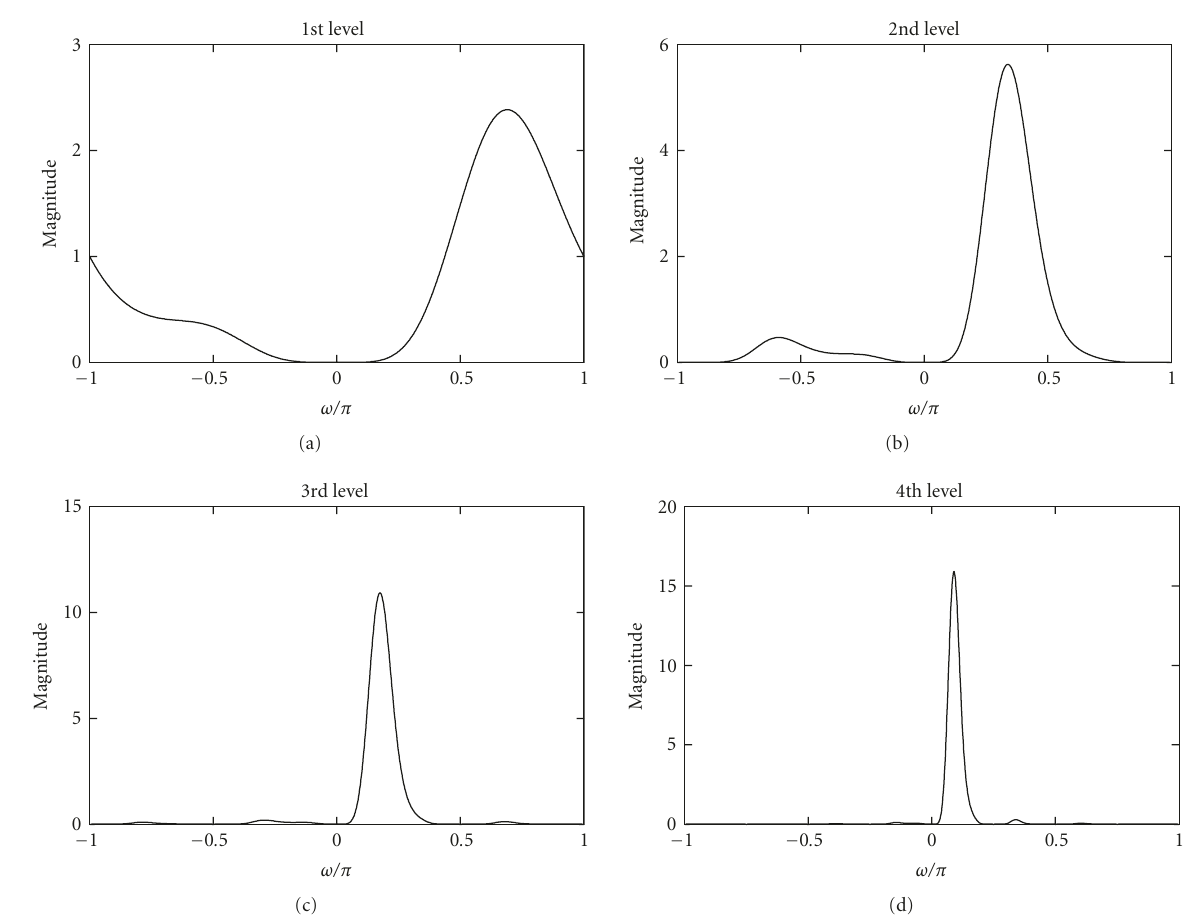
Figure 9: Frequency response of 1-dimensional wavelets in the first 4 levels for the ST-CWT (length 10 complex filters from Table 1).